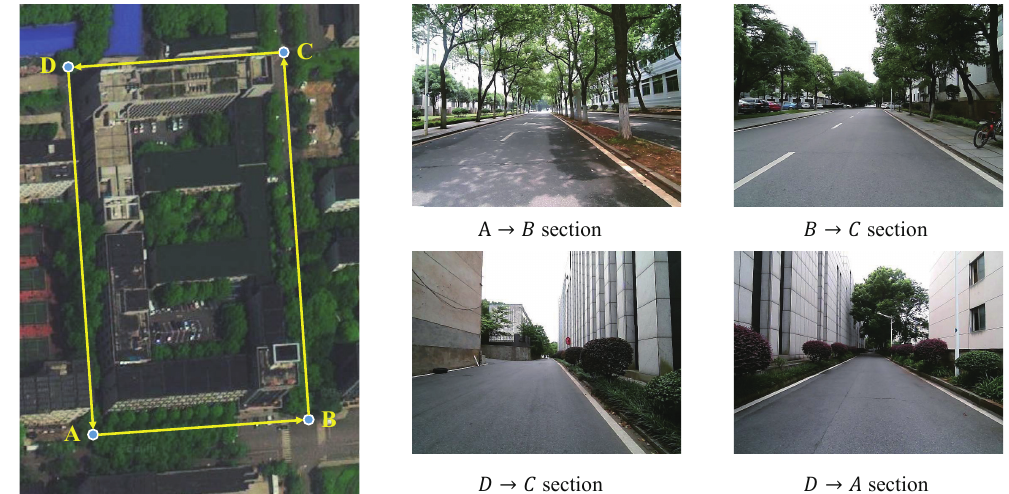
Figure 12. The real experimental